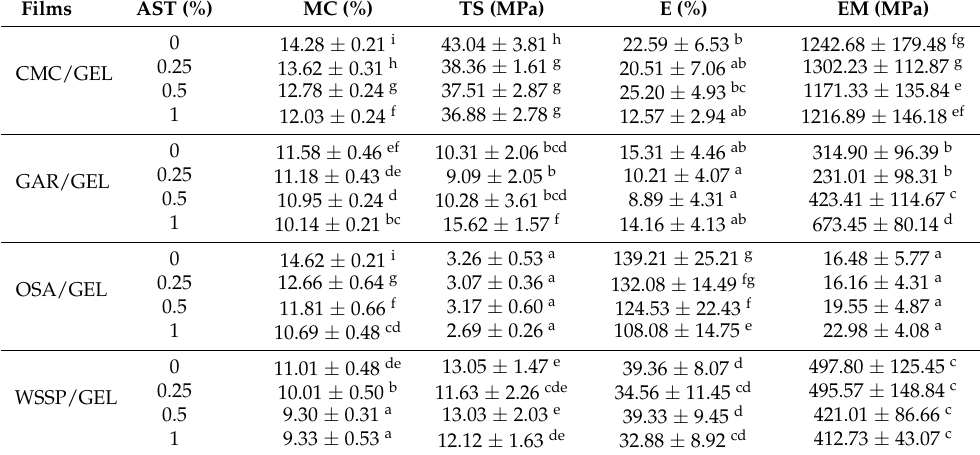
Table 1. The effect of Astasana (AST) concentration on the moisture content (MC), tensile strength (TS), elongation at break (E), and elastic modulus (EM) of 75/25 blend films obtained from polysaccharides: carboxymethyl cellulose (CMC), gum Arabic (GAR), octenyl-succinic-anhydride-modified starch (OSA), water-soluble soy polysaccharides (WSSP), and gelatin